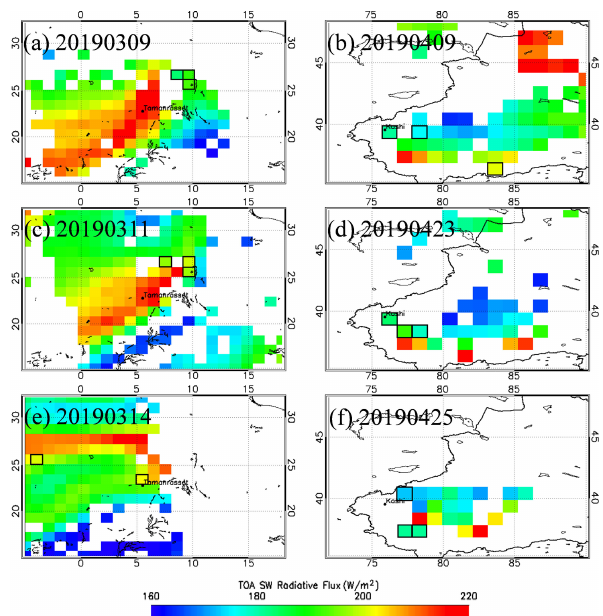
Figure 9. SBDART-simulated clear-sky TOA radiative flux by us- ing integrated water vapor (g/cm 2 ) from the ECMWF reanalysis dataset over the Sahara in March 2019 and over the Taklimakan Desert in April 2019.